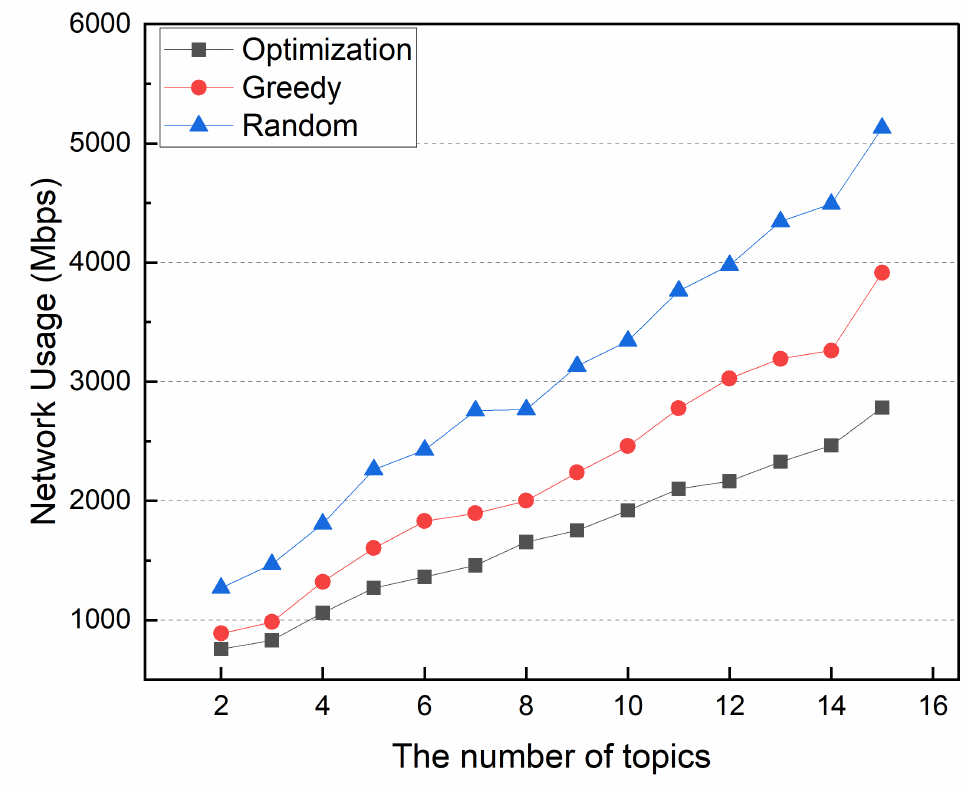
Figure 18. Network usage according to the number of